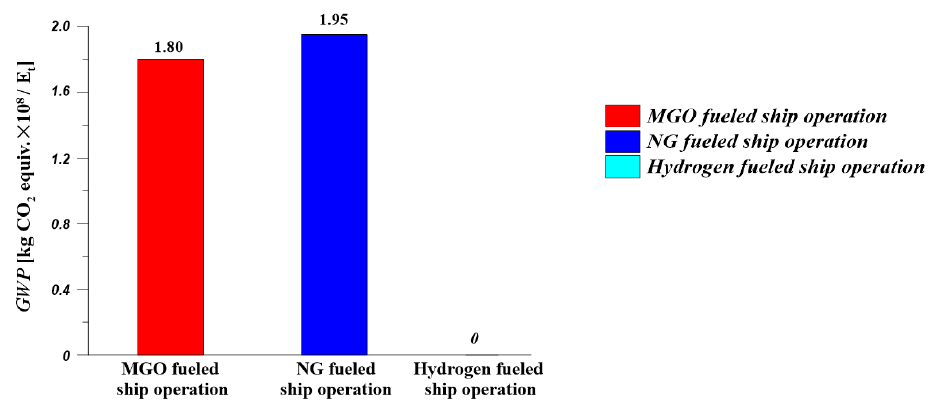
Figure 8. GWP at the Tank-to-Wake phase from MGO, natural gas, and hydrogen.